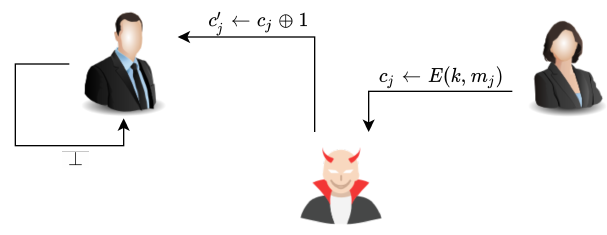
Figure 28. Resistance of the proposed scheme to the malleability attack.